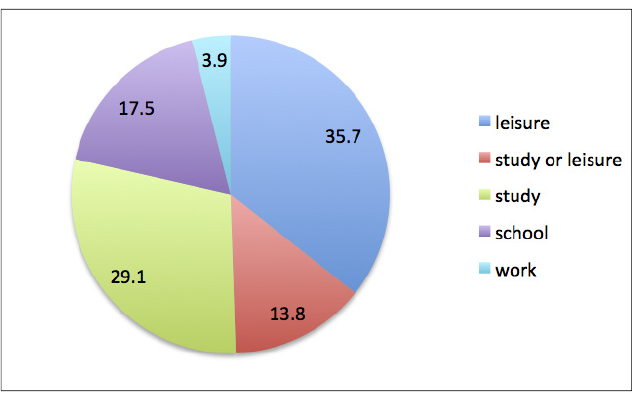
Figure 3. Contexts/motivations of non-spam question in the corpus